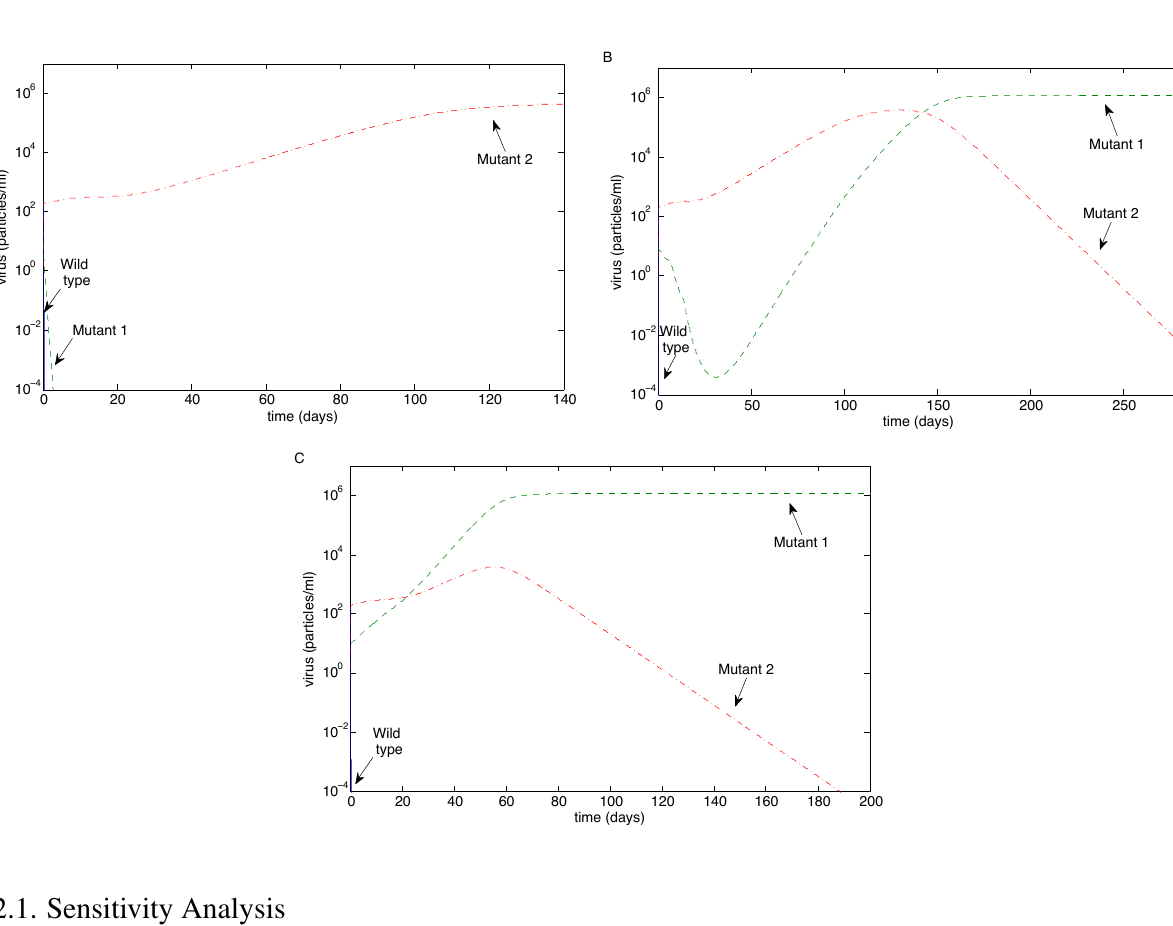
= 2 . 7 × 10 1 ). Here, 2